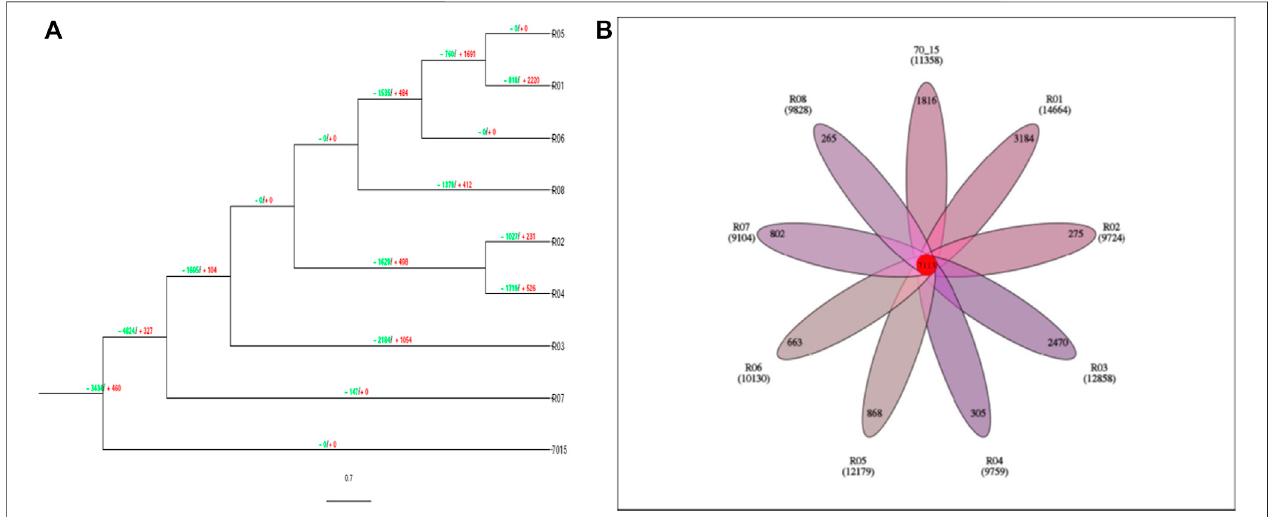
FIGURE4|(A) Evolutionarybranchdiagramofgenefamilyexpansionandcontraction.Thetreeisrootedon70-15strain.Thegreenvaluesrepresentthereduction while values in red represent the gene expression. (B) . The Venn diagram reveals the common ortholog conserved among the rice blast fungus strains. The numbers highlighted in red color represent the common orthologs, while the branch numbers represent the endemic gene families.